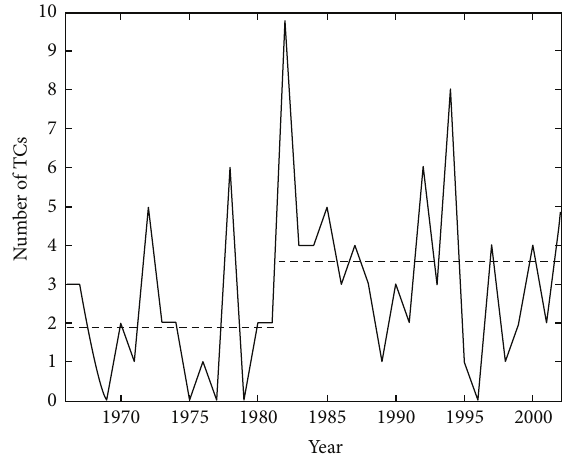
Figure 1: The time series of tropical cyclones number in the central of North Pacific during 1966–2002 and its MCMC detection results